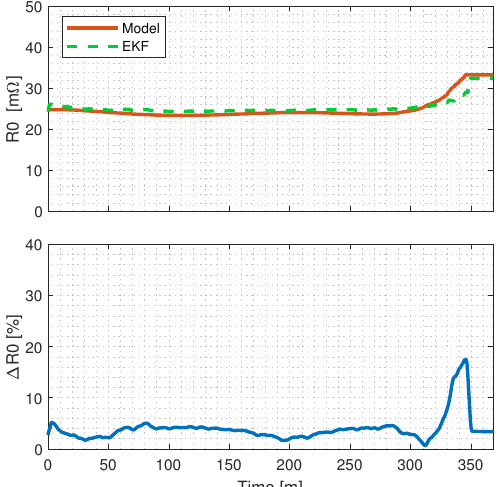
Figure 10. LG 1-A. Comparison between the internal resistance R 0 estimated by the GO-EKF and the resistance used in the reference